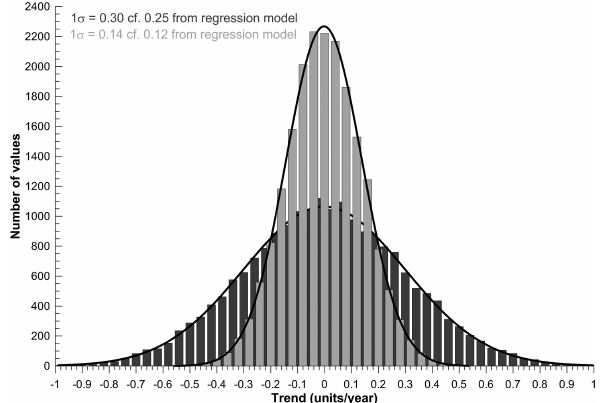
Figure 4. Histograms generated from 20000 simulations of trend results derived from the application of Eq. (1) to synthetic time se- ries (as shown in Fig. 3a) first with the original solar cycle and QBO basis functions (dark grey) and then with detrended QBO and solar cycle basis functions (light grey). The 1 σ standard deviations of Gaussian fits to the histograms are listed together with the mean trend uncertainties derived from the regression model. The mean uncertainties were obtained by averaging the uncertainties from the 20000 trend